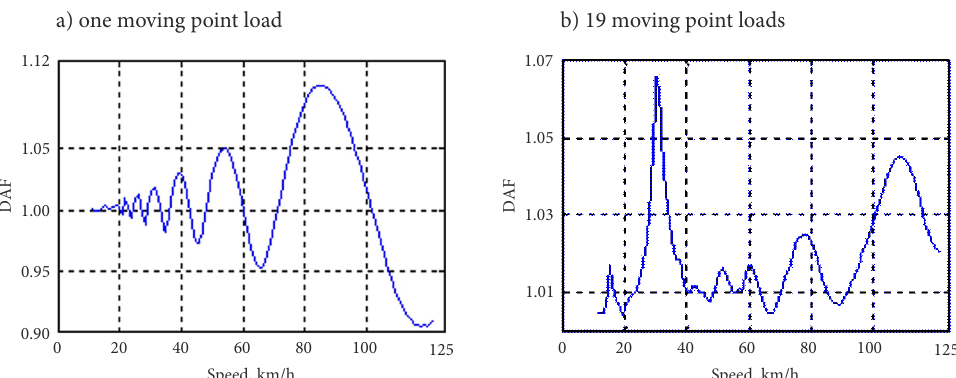
Figure 5. DAF-speed pattern due